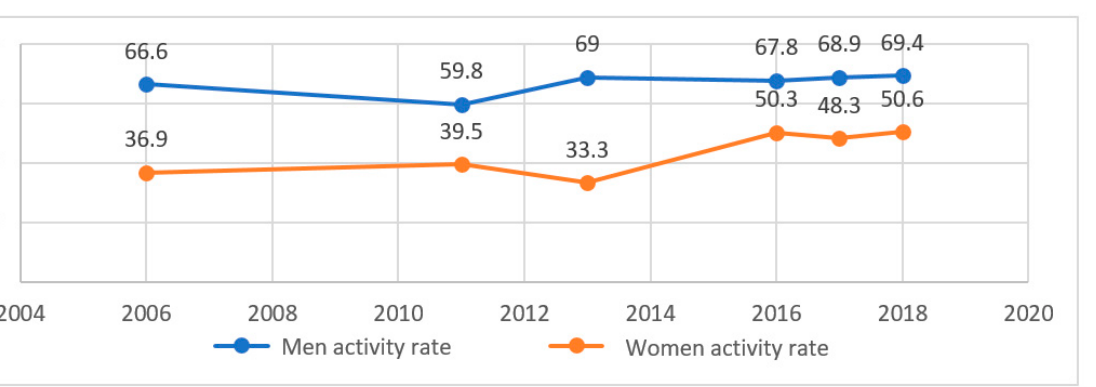
Figure 1. Evolution of the activity rate by gender. Source: Authors, based on ANSD data. The same trend can be observed in terms of the employment rate. Even if the employ- ment rate of men is much higher than that for women, there was a slight increase in the rate of men from 53.6% in 2006 to 57.3% in 2018, while that of women markedly increased from 25.5% to 32.3% between 2006 and 2018 (see Figure 2).